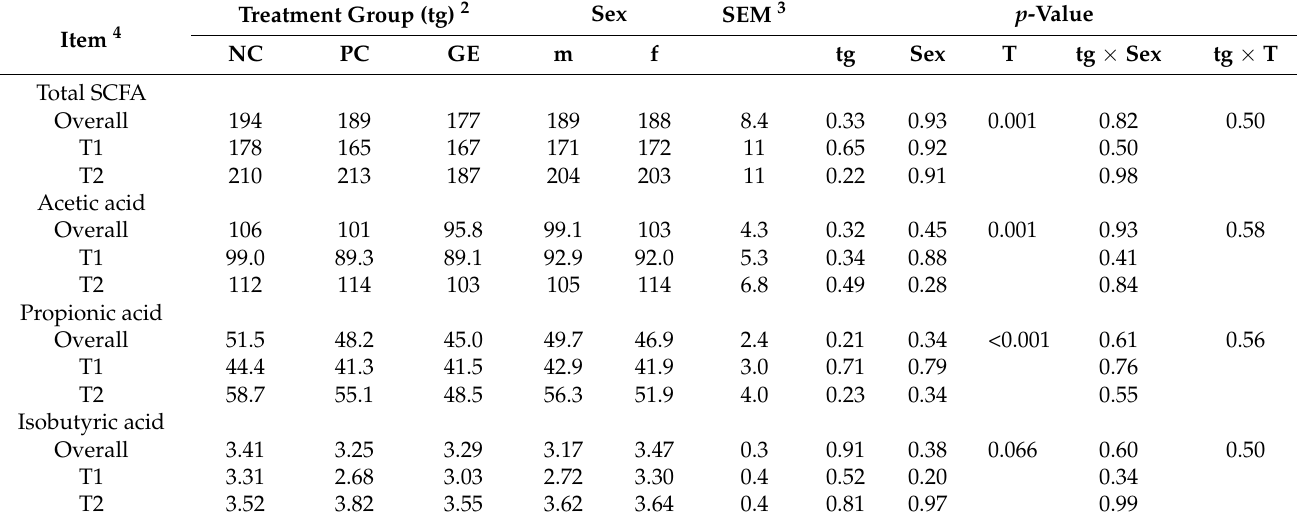
Table 6. Effect of using NC and PC for testing dietary GE supplementation on the concentrations of SCFA (mmol/kg) and lactic acid (mmol/kg) in colonic content of weaning piglets in two different sampling points 1 . Item 4